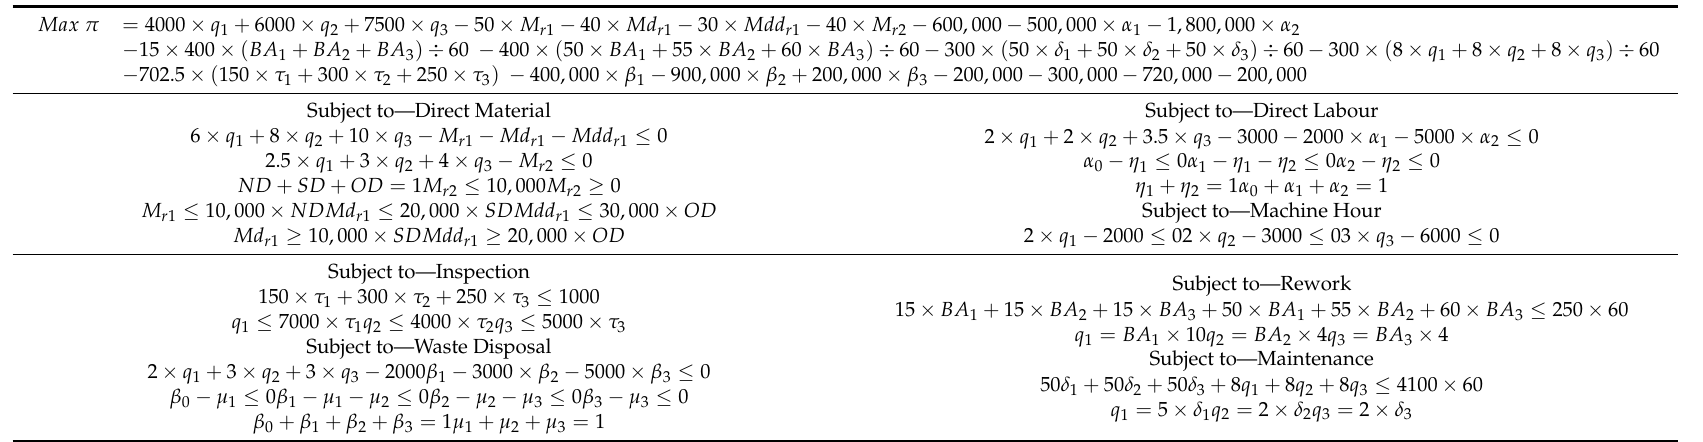
Table A1. The quality management decision model for current capacity without carbon tax (Scenario